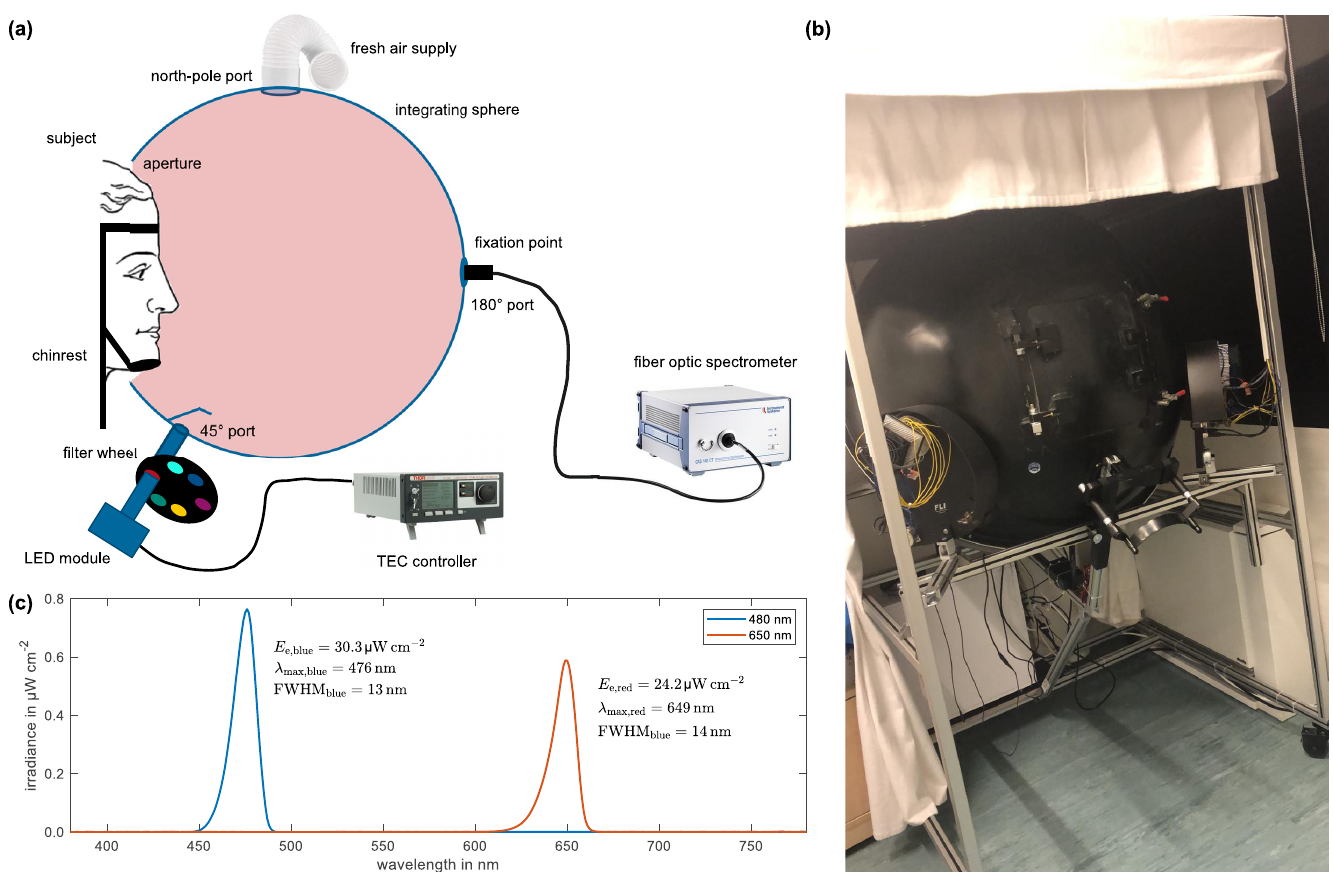
Fig 2. Overview of the experimental setup and test light conditions. A: Schematic illustration of the individual components of the experimental setup. Homogeneous illumination of the participants’ entire visual field is provided by using a large integrating sphere collecting the light emitted by a narrow-band LED- based temperature-stabilized light source. A fiber optic spectrometer mounted to the 180˚ port of the integrating sphere in combination with a calibrated photodiode placed at the participants’ right eye position is used for calibration. An integrated fresh air supply as well as the explicit control of room temperature and humidity guarantee constant ambient conditions across all test sessions. B: Image of the experimental setup as it can be found in the sleep laboratory. When not in use, the aperture door is closed with the chinrest in a stowed position to prevent dust from settling inside the sphere. C: Calibrated light spectra of both test conditions adjusted to deliver equal photon